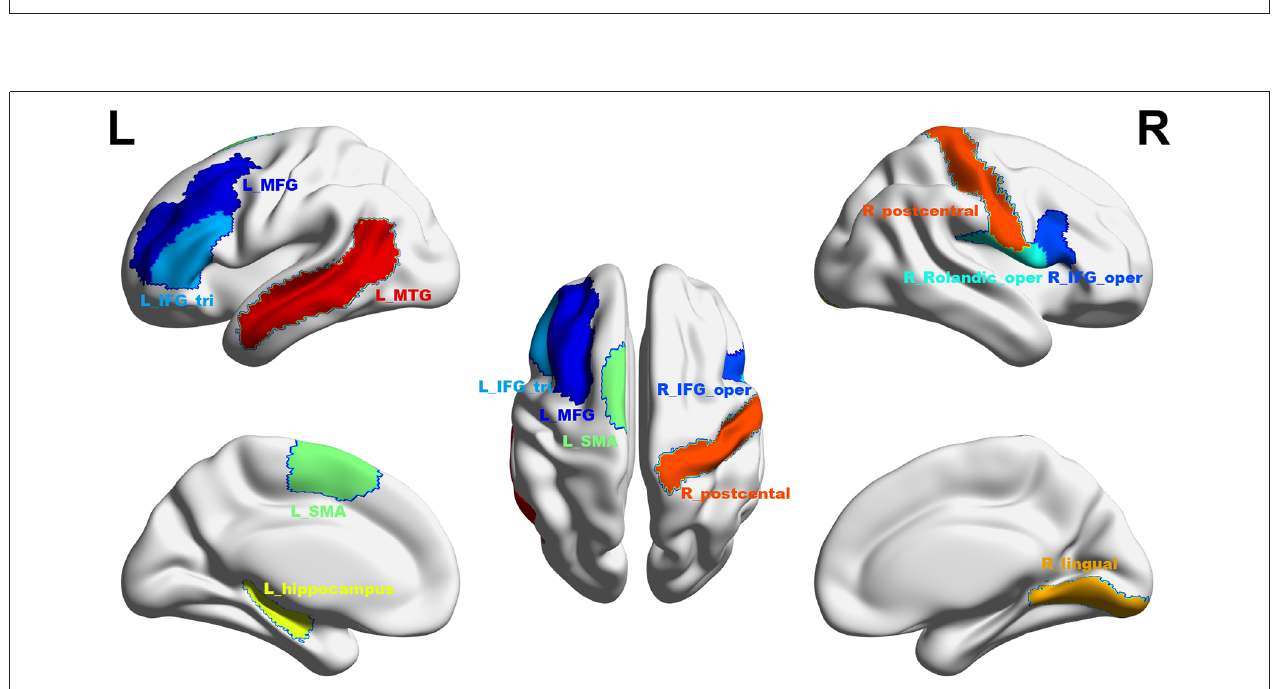
FIGURE 4 | Behavioral results. After SD, subjects showed significantly poorer performance on SSRT ( p = 0.03, A ). The SSRT of RW was significantly negative correlated with (cid:49) SSRT ( r = − 0.596, p < 0.001, B ). The SSRT of RW in vulnerable group was significantly faster than that in resilient group ( p = 0.004, C ). ∗ p < 0.05; ∗∗ p < 0.01.